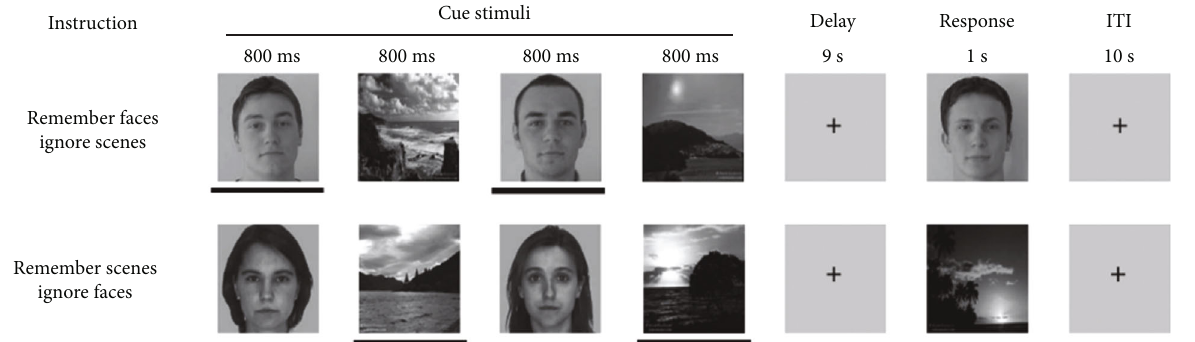
Figure 3: Experimental framework. The two subtasks di ff er only in the instructions given at the beginning of each run, instructing the participant which, if any, stimuli they should attempt to remember over a 9s delay, and in the response requirements. In the response period of the two memory tasks, a face or scene stimulus was presented (corresponding to the relevant stimulus class), and participants were required to report with a button press whether the stimulus matched one of the previously presented stimuli.